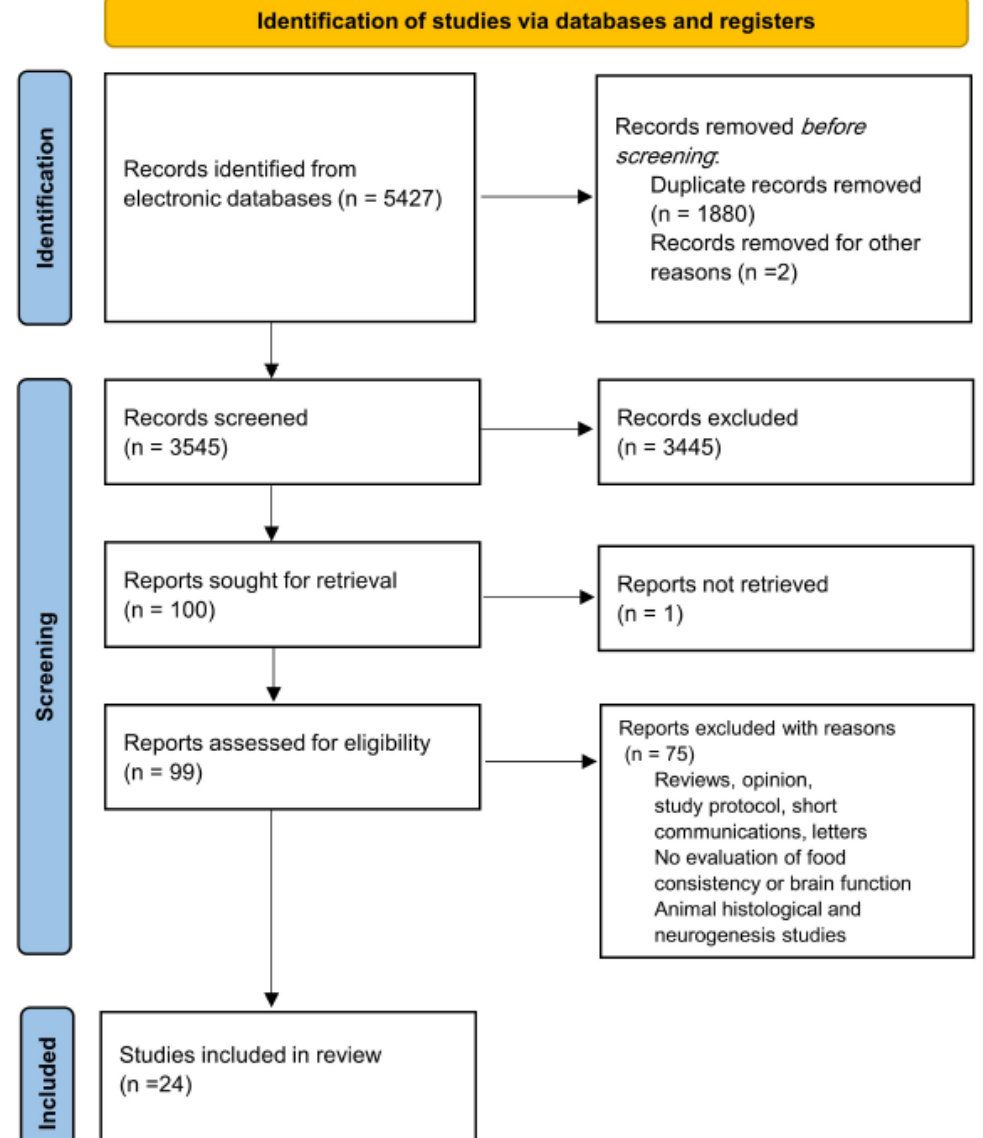
Figure 1. PRISMA flow diagram showing the screening and study selection.